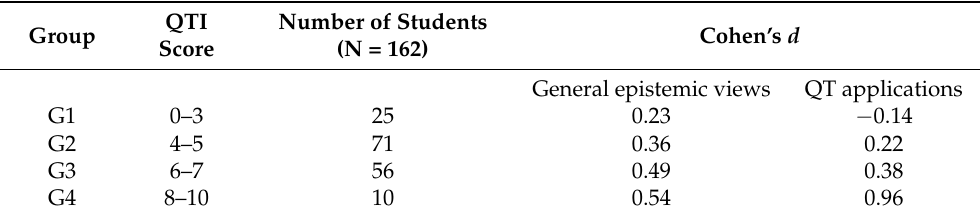
Figure 9. Pre-instruction vs. post-instruction average scores of the VAQT instrument (applications of quantum technologies) according to the performance in the QTI for four groups (see Table 3). Table 3. Sample subdivision and pre-post effect size for the views about quantum technologies (VAQT) instrument according to QT performance